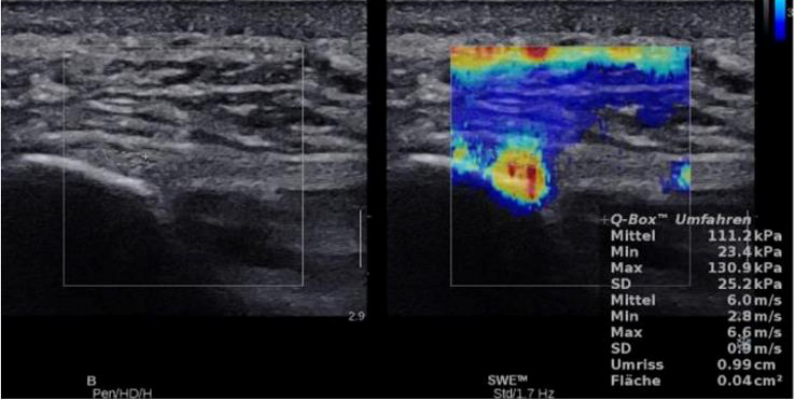
Figure 3. Longitudinal SWE image and B-mode ultrasound image of a 30 years old healthy volunteer with normal plantar fascia demonstrates stiffness of 111.2 kPa and SWV value of 6.0 m/s.